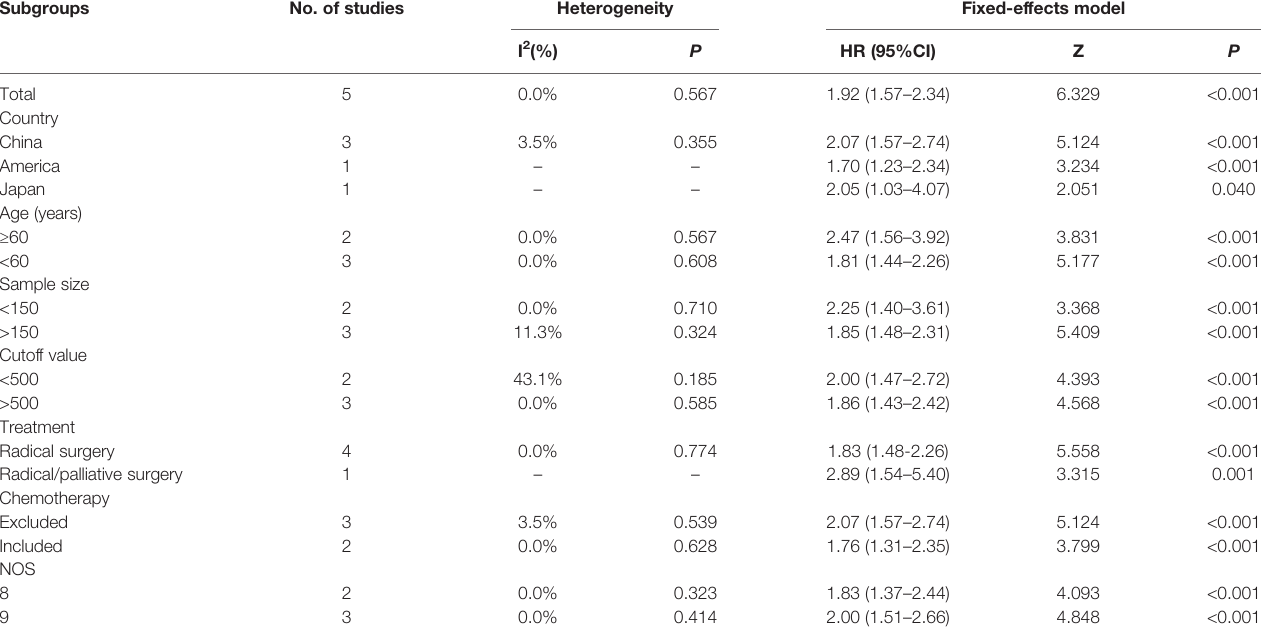
TABLE 3 | Subgroup analysis for OS.